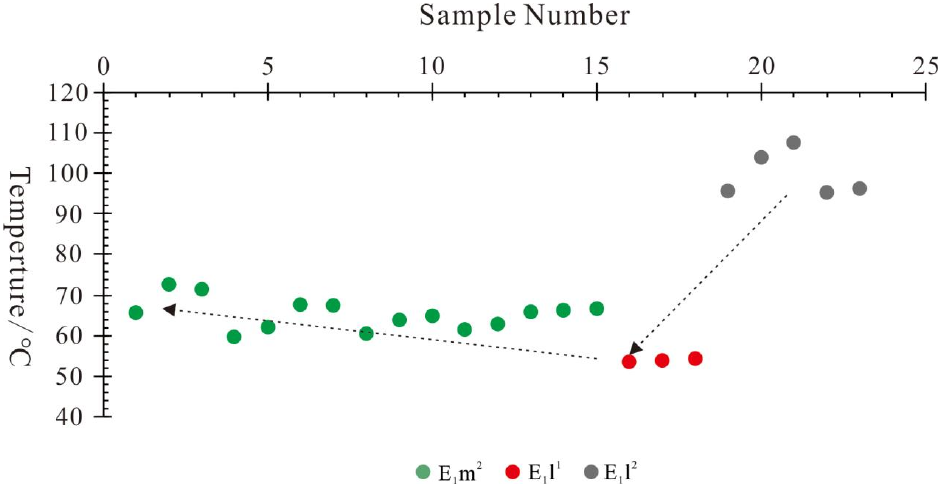
Table 3. The test data of the whole rock carbon and oxygen stable isotopes of sandstone in the West Lishui Sag (according to Shanghai Branch Company of CNOOC).